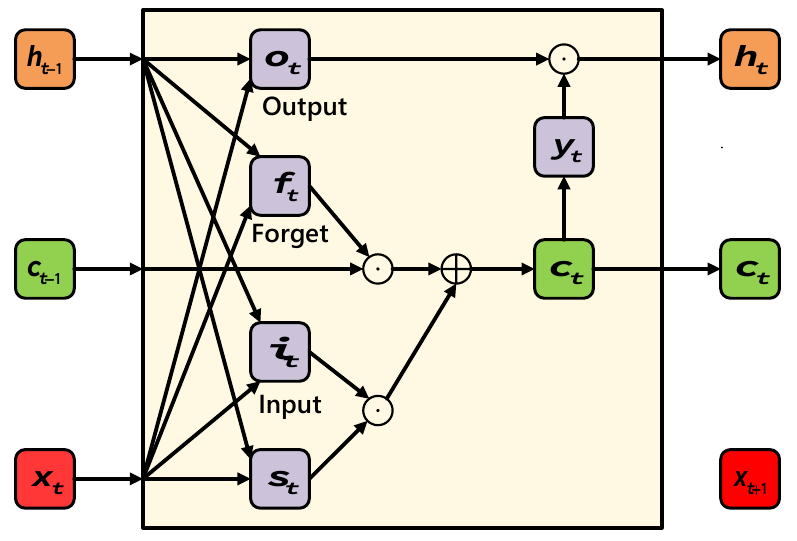
Figure 4. LSTM structure.